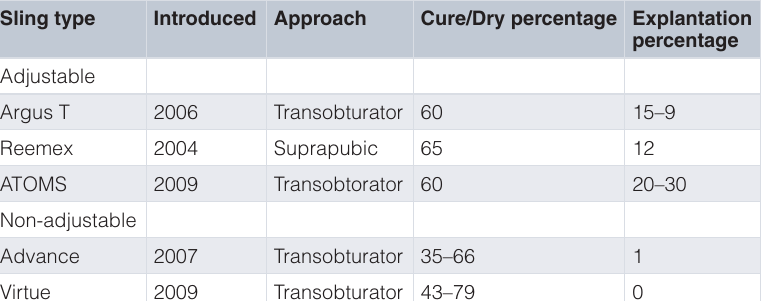
Table 6. Results of male sling surgery for stress